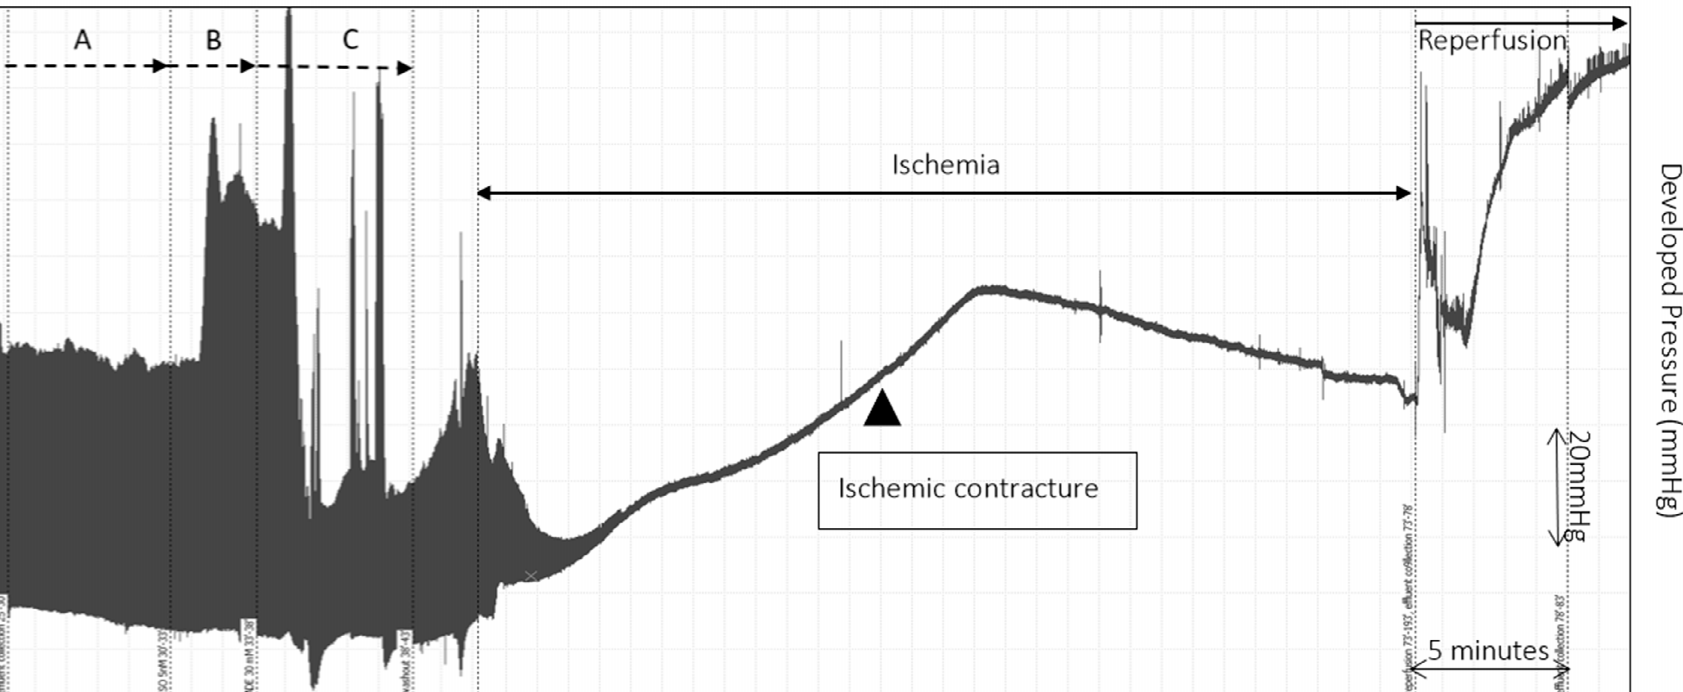
Figure 3. A representative experimental trace of changes in LV pressure (mmHg) measured before interventions (A), during Isoproterenol (B) and Adenosine (C) and during Ischemia and early reperfusion. Arrowhead shows the gradual increase in developed pressure that is a measure of ischemic contracture (rigor). Y -axis shows the developed pressure in mmHg and X -axis shows time in minutes. Scales are shown on the right-hand side of the trace.